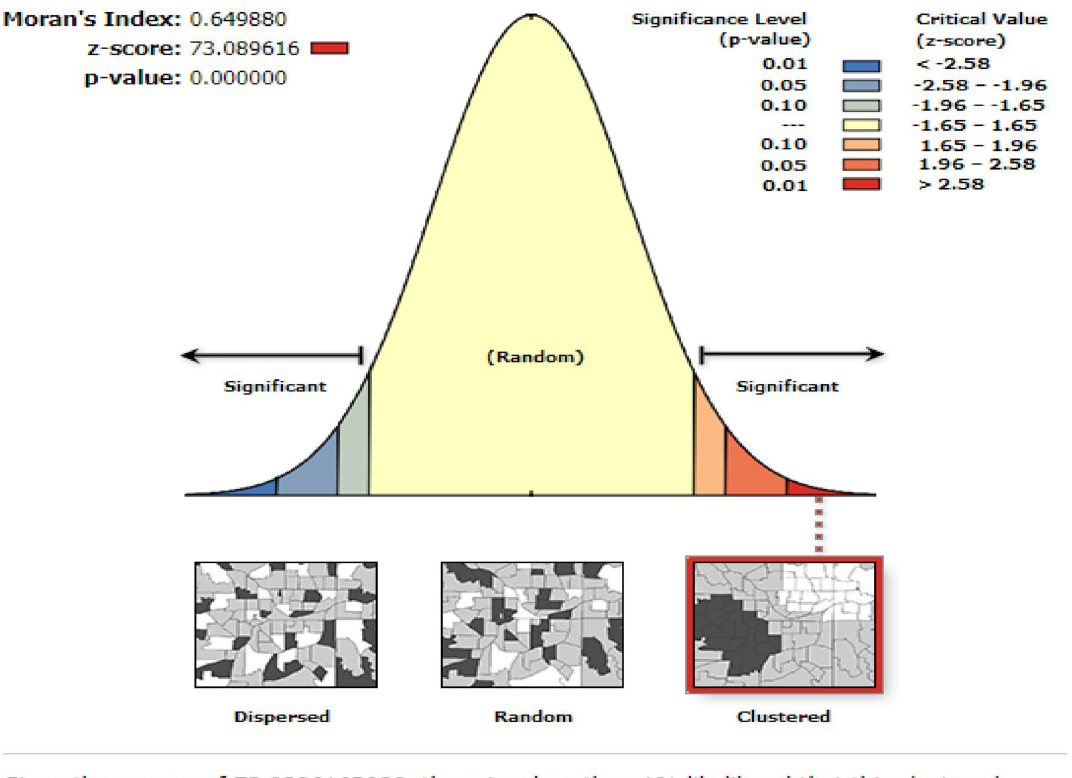
Figure 3. A global spatial autocorrelation analysis to explore the spatial pattern non-resilience to food insecurity during COVID-19 pandemic in East Gojjam Zone, Northwest Ethiopia,